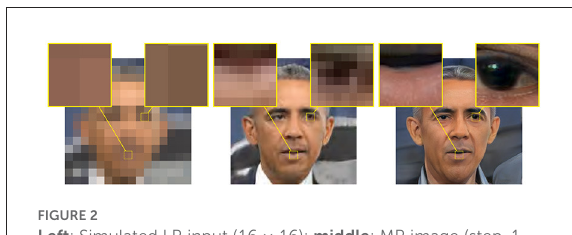
FIGURE2 Left : Simulated LR input (16 × 16); middle : MR image (step-1 output, 128 × 128); right : HR final (step-2 output, 1024 ×